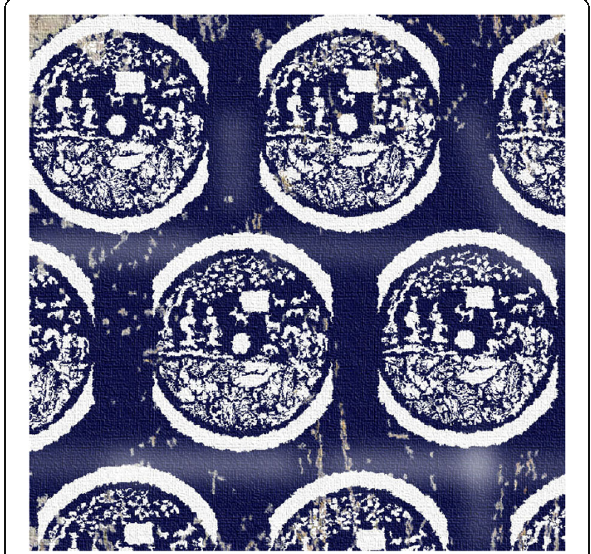
Fig. 7 Computer simulation tie-dye pattern